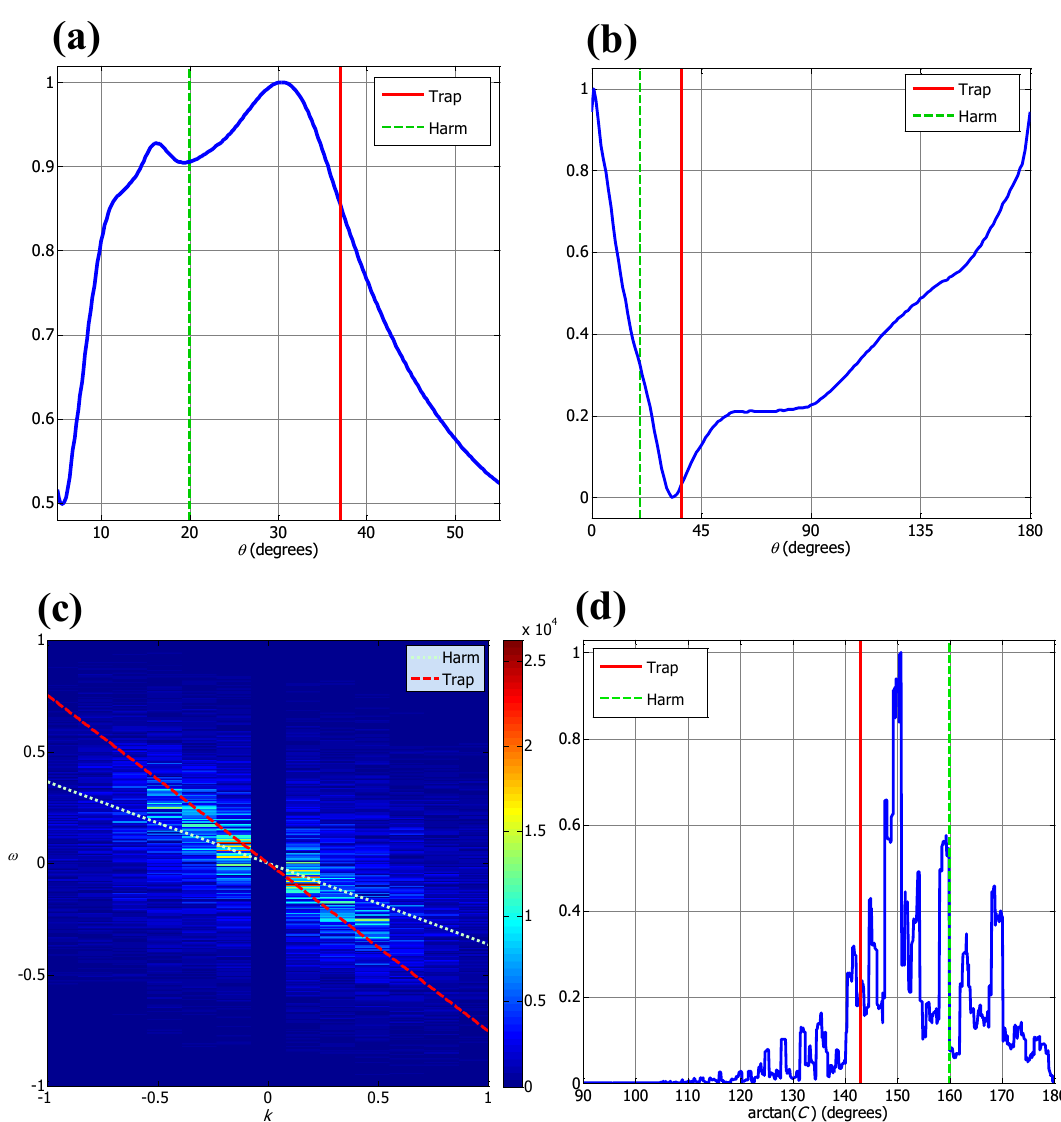
Figure 4. Analyses of the phase speeds of the Hovmöller diagram of Fig. 3b. (a) Solid blue curve: the sum of squares of the Radon transform as a function of θ (near the peak) normalized such that the maximum value equals 1; Dashed green vertical line: the angle of the harmonic wave theory (Eq. 2); Solid red vertical line: the angle of the trapped wave theory (Eq. 4). The same two vertical lines appear also in panels (b) and (d) . (b) Solid blue curve: the distribution of the mean of variances versus θ , normalized such that the maximum (minimum) value equals 1 (0). (c) The 2D FFT frequency–wavenumber diagram in the low-frequency–low-wavenumber regime ( k is measured in units of (1 / 4 ◦ of longitude) − 1 , ω is measured in units of week − 1 and the amplitude units are arbitrary). Dashed red line: trapped wave’s phase speed, Eq. (4); dotted light-green line: harmonic wave’s phase speed, Eq. (2). (d) The distribution of the sum of squares of the 2D FFT amplitudes along different lines (sweeping) versus arctan( C ), normalized such that the maximum value equals 1 (solid blue curve). Only values of 90 ◦ < arctan( C ) < 180 ◦ are shown since only these values correspond to westward propagating